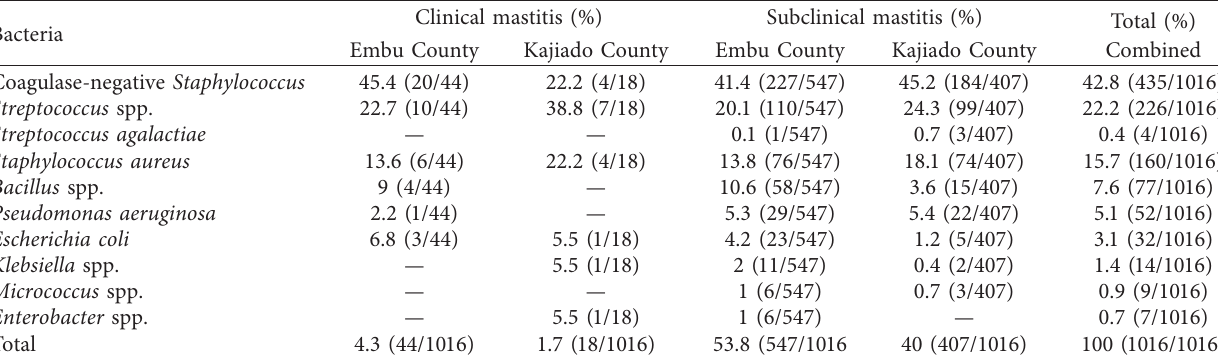
Table 1: Summary table of the distribution of bacteria isolated from clinical and subclinical mastitis in Embu and Kajiado counties, Kenya. Clinical mastitis Bacteria